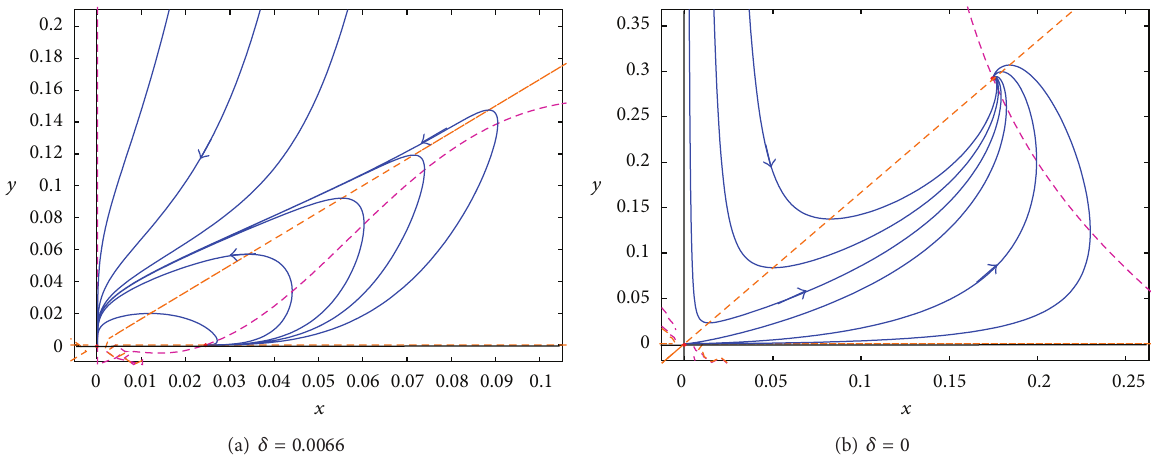
Figure 7: The same ratio-dependent predator-prey system with and without a mate-finding Allee effect for 𝑔 = 1.3 , 𝛼 = 0.2 , 𝛼 1 = 0.8 , and 𝛽 = 0.3